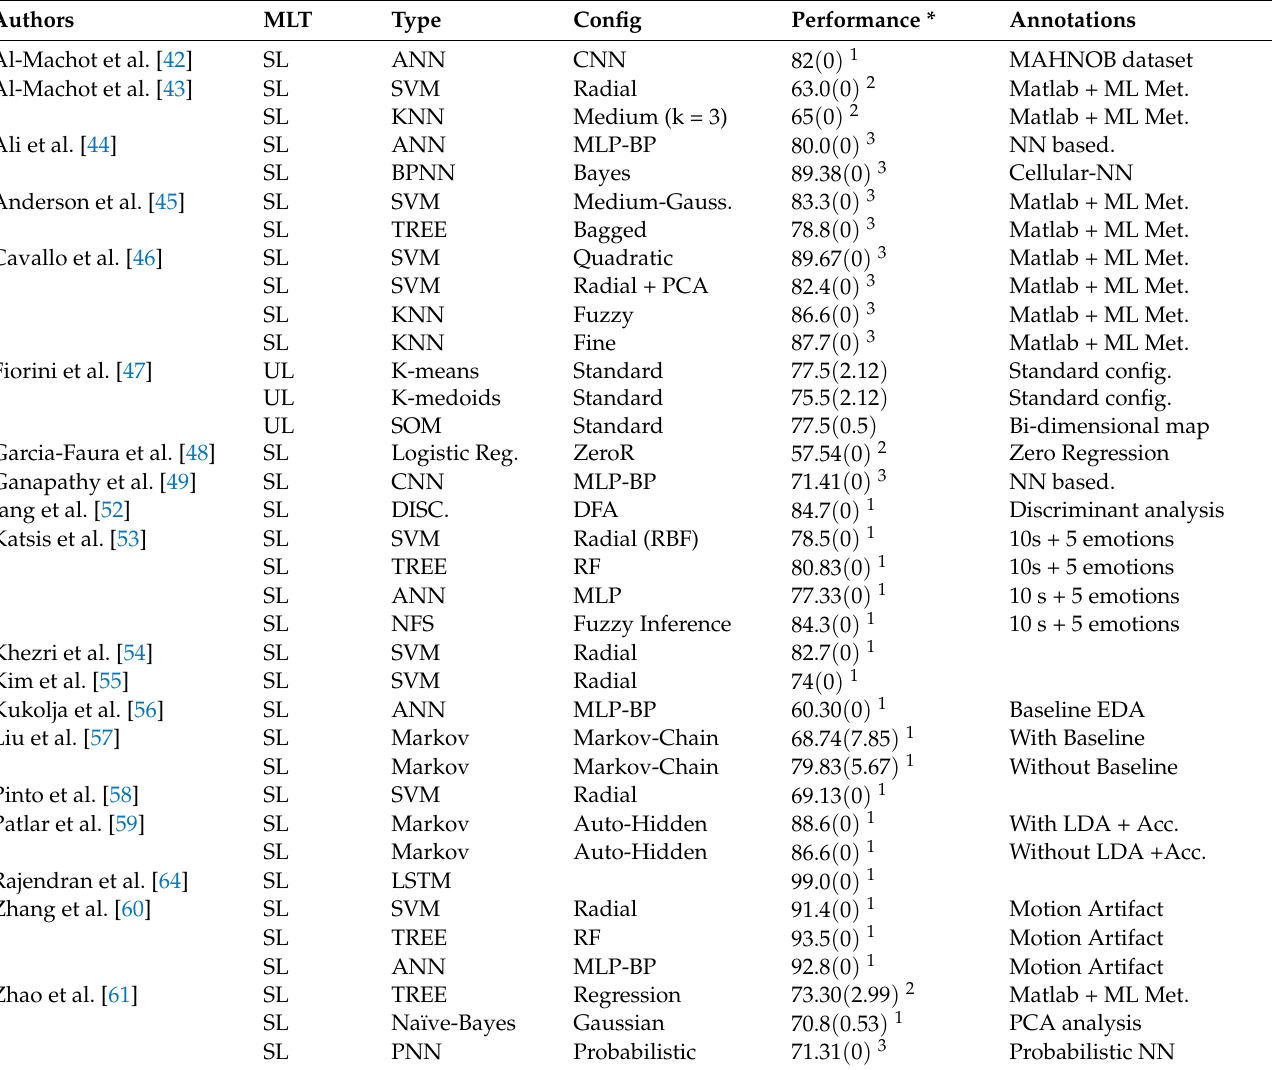
Table 13. Supervised learning methods for emotion classification.